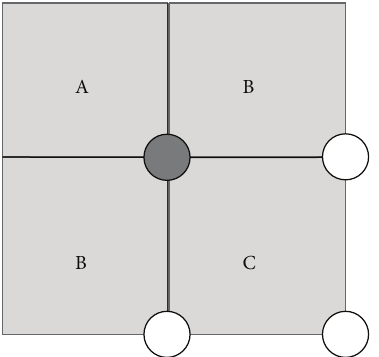
Figure 9: Constellation diagram and ACE decision regions for the marked symbol of 4-QAM.